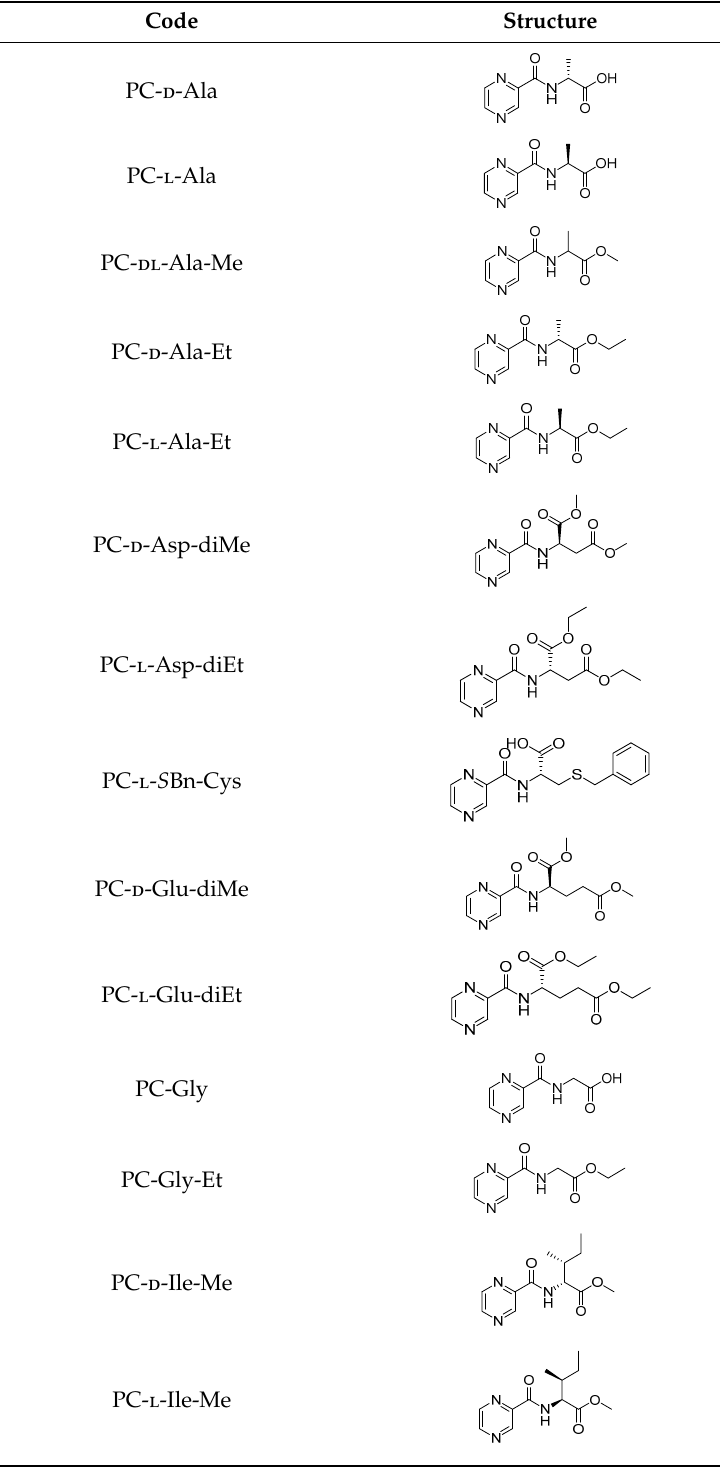
Table 1. Structures of the synthesized compounds.